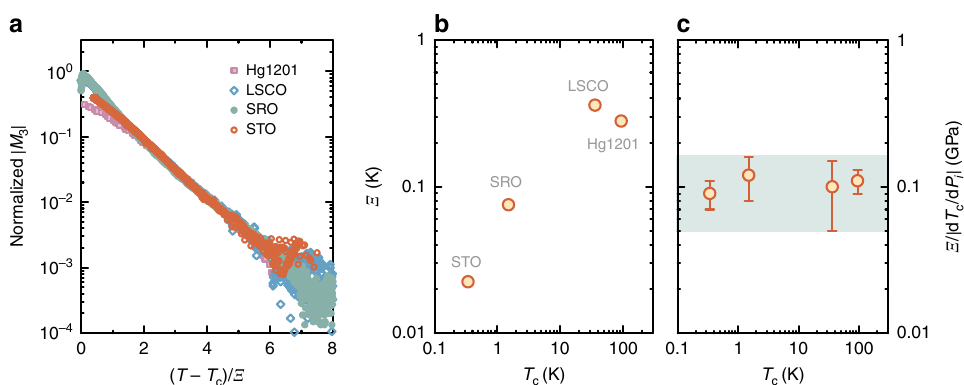
Fig. 2 Characteristic pre-pairing scale. a Scaling plot of the raw data from Fig. 1, demonstrating the universality of the precursor response. The temperature axis is scaled by the slopes of the exponential dependences, Ξ , and the curves are multiplied by constant factors to obtain collapse on the vertical axis. High-frequency data from Fig. 1 are used, except for STO where we combined both data sets. b The slopes Ξ plotted against the T c values of the studied compounds. Errors are obtained from exponential fi ts and are smaller than the symbol size. The exponential fi ts show high fi delity, as seen in the low values of the reduced sum of residuals (Table 1). c Ξ normalized to the derivative of T c with regard to uniaxial stress (Table 1). For STO, the derivatives dT c / P a , dT c / P dT c / P b , and c with respect to the three principal crystallographic directions are similar owing to the nearly cubic structure. For SRO, LSCO, and Hg1201, we take values of dT c / dP i with the pressure applied within the RuO 2 and CuO 2 planes. For SRO, the dependence of T c on P a is nonlinear, and we take the average slope between T c = 1.5 K and T c = 2 K. The nonlinearity may be the cause of the slight curvature seen in Fig. 1b. The turquoise band indicates the estimated uncertainty range, and the error bars are obtained directly from the uncertainties of dT c / dP i (see Table 1).